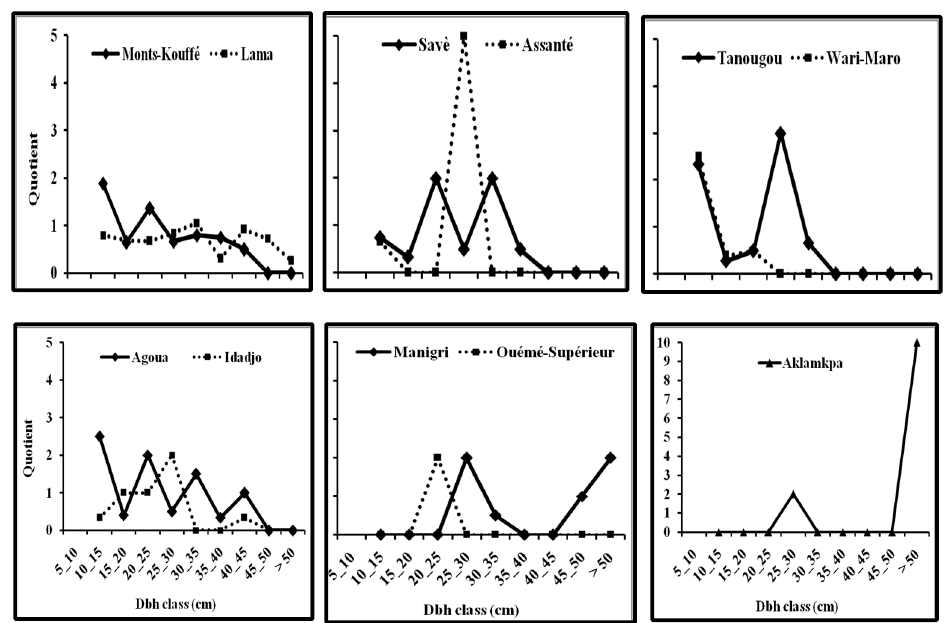
Figure 4. Quotients between numbers of trees in successive size classes; Lama, for M . andongensis, and the other forests for M . kummel .